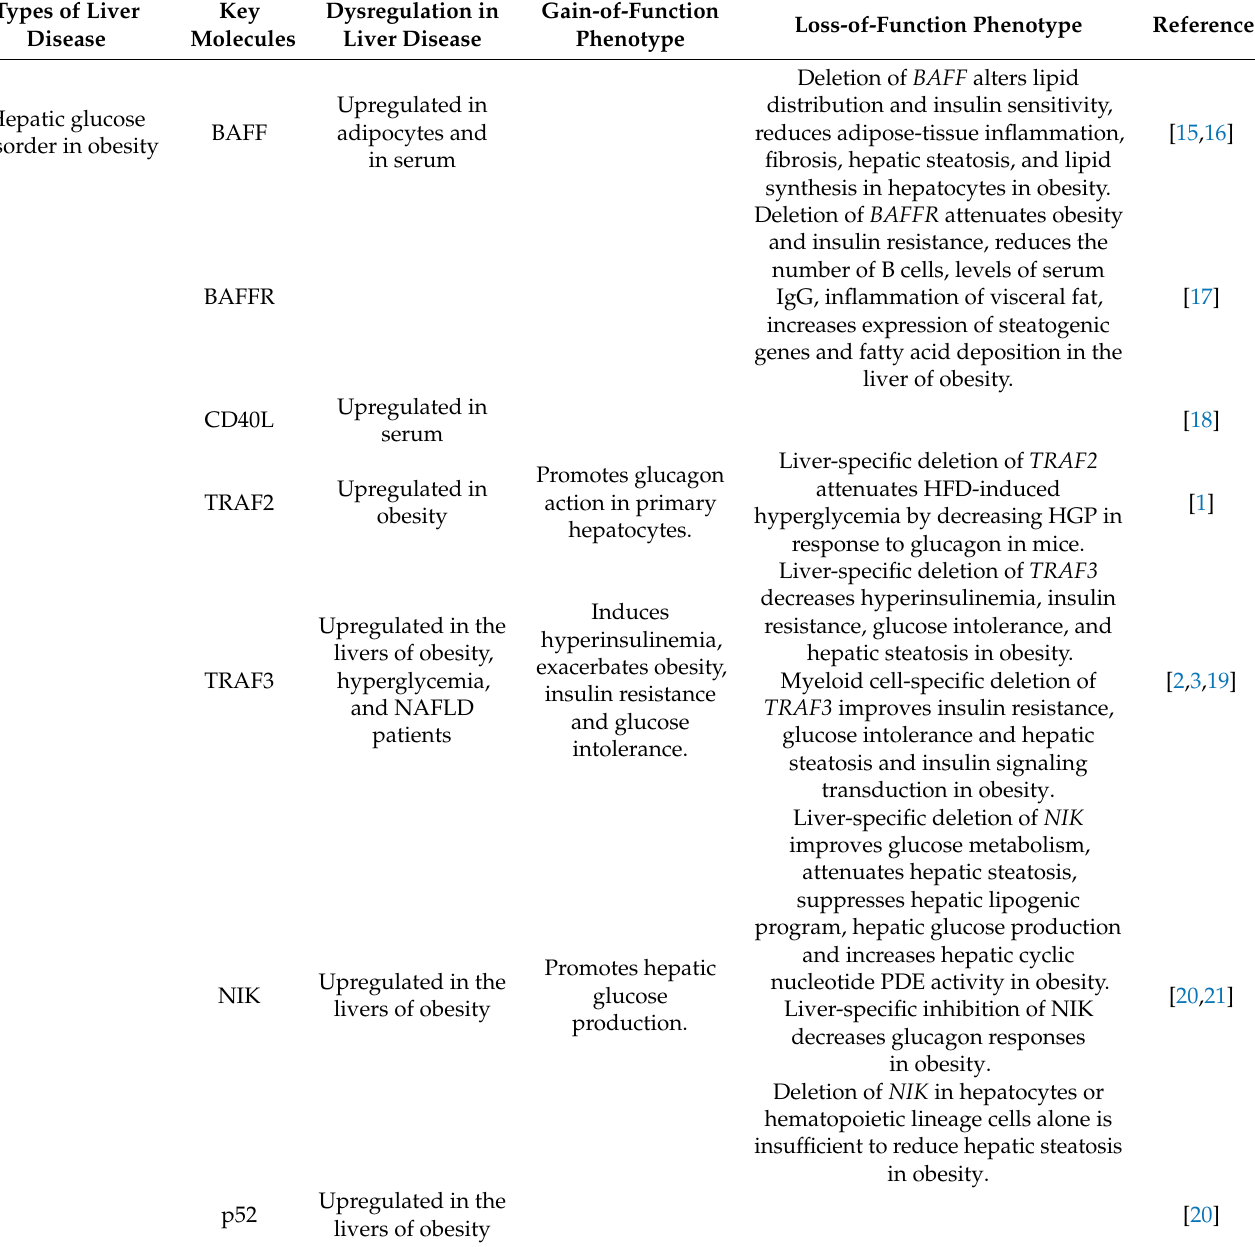
Table 1. Key molecules of non-canonical NF- κ B signaling pathway regulate liver